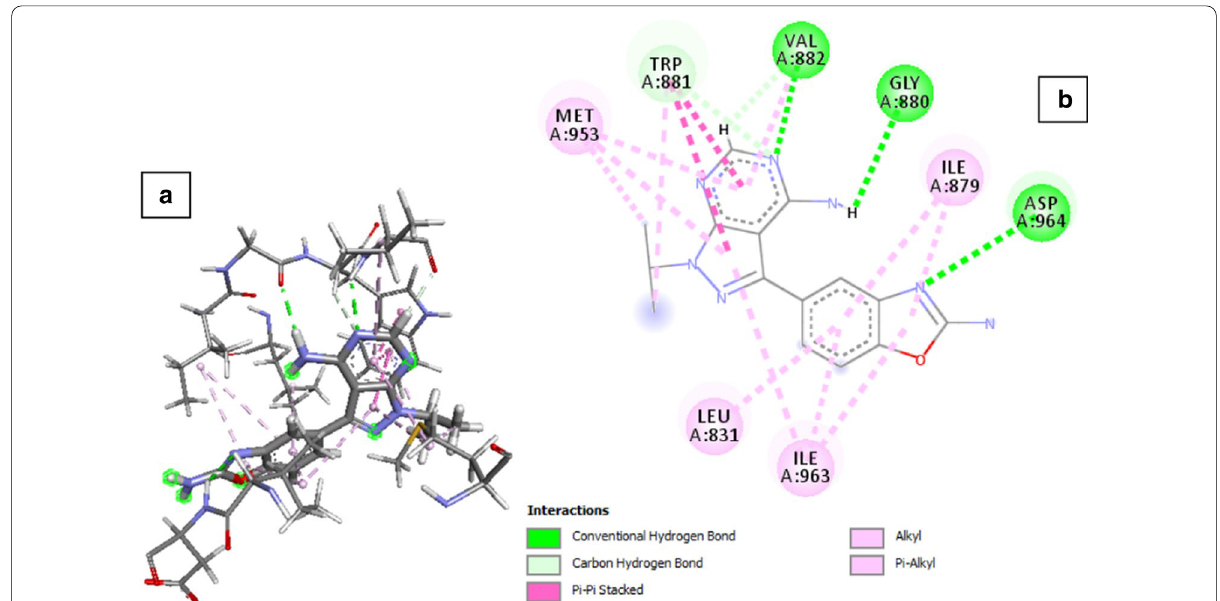
Fig. 9 3D and 2D binding pose interaction of INK 128 (MLN0128)- mTOR kinase complex in a and b respectively. 2D 2dimension, 3D